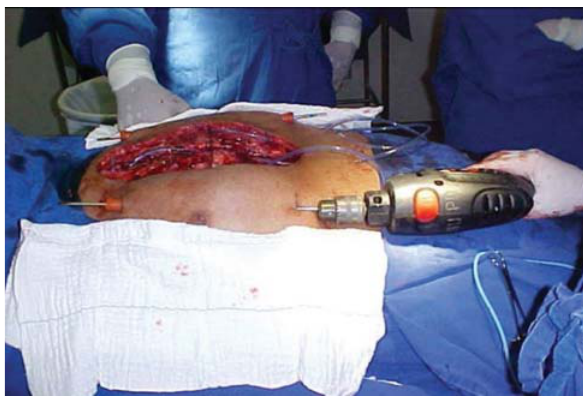
Fig. 3 - Colocação dos fios de Kirschner